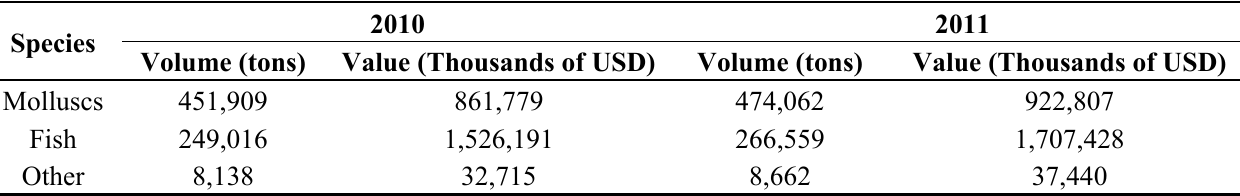
Table 2. Production volume and value of marine aquaculture in Mediterranean countries in 2010 and